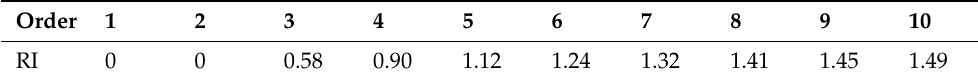
Table 5. Value of RI .